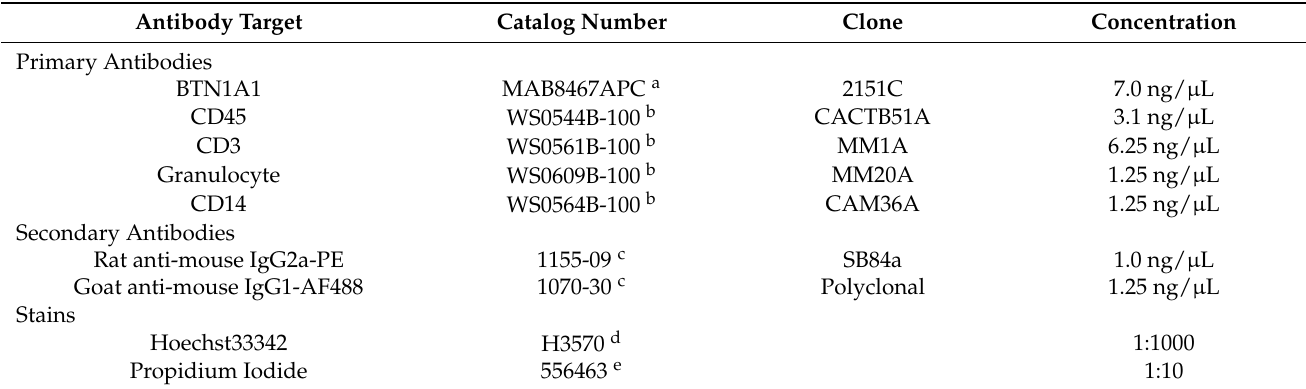
Table 1. Antibodies used to label milk somatic cell populations for flow cytometry